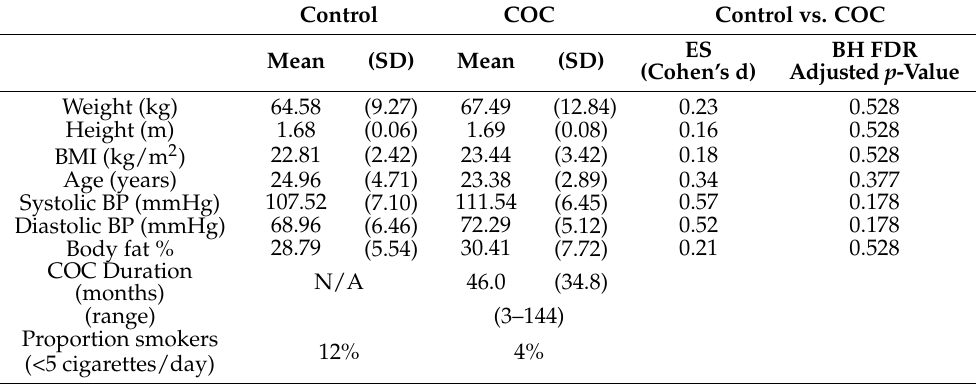
Table 1. Baseline characteristics of study population. ES, effect size. Cohen’s d value: 0.2, small